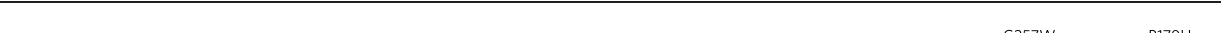
expressing alleles by western blot when compared to other HDAC isoforms in human VSMCs. Three experimental replicates are quanti fi ed. b Immunoprecipitation of BRG1 demonstrates HDAC9 binding in TGFR2 G357W and ACTA2 R179H expressing mutant cells. Quanti fi cation of protein levels of three replicate experiments. c Top, CLIP-seq analysis of anti-HDAC9 and anti-BRG1 immune complexes illustrated by Venn diagram showing the number of transcripts detected by puri fi cation with both antibodies at baseline or during expression of TGFR2 G357W or ACTA2 R179H alleles. Bottom, cellular function of 107 core transcripts by ingenuity pathway analysis. d Quantitative PCR analysis of known cardiovascular lncRNAs during the expression of TGFR2 G357W or ACTA2 R179H alleles. e Quantitative PCR analysis of cardiovascular lncRNAs associated with either anti-HDAC9 or anti-BRG1 immune complexes. Four experimental replicates are quanti fi ed. f Serial immunoprecipitation of BRG1 and HDAC9 demonstrates the association of the lncRNA MALAT1 with BRG1- HDAC9 immunocomplexes. Quanti fi cation of protein levels of three replicate experiments. g Western blot analysis of HDAC9 and BRG1 proteins captured through UV crosslinking of bead immobilized biotinylated MALAT1 or LacZ antisense RNA probes. Three replicates are quanti fi ed. h Immuno fl uorescence of HDAC9 and BRG1 demonstrate lack of nuclear localization of HDAC9 in siMALAT1-treated cells. Bar = 15 µ M, circles indicate nuclei location in siMALAT-treated cells, arrows indicate apparent cytoplasmic HDAC9 aggregates. i Semiquantitative western blot analysis of HDAC9 and HDAC1 from nuclear extracts (NE) and cytoplasmic extracts (CE) from control and siMALAT1-treated VSMCs. j siMALAT1 treatment of VSMCs decreases TGFR2 G357W or ACTA2 R179H mediated induction of MMP activity by in vitro gelatin zymography. Bar graphs are presented as mean with error bars